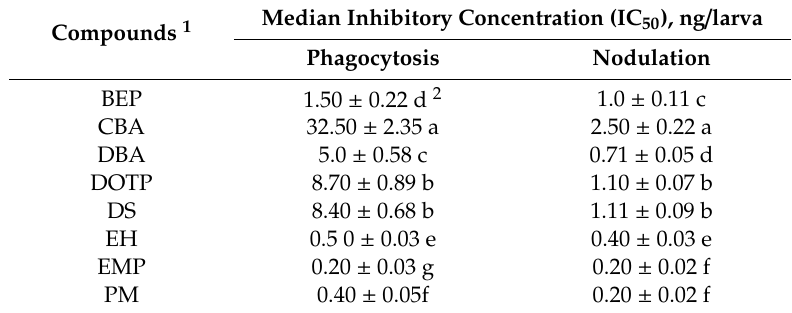
indicate significant di ff erence among means in each column at Type I error = 0.05 (LSD